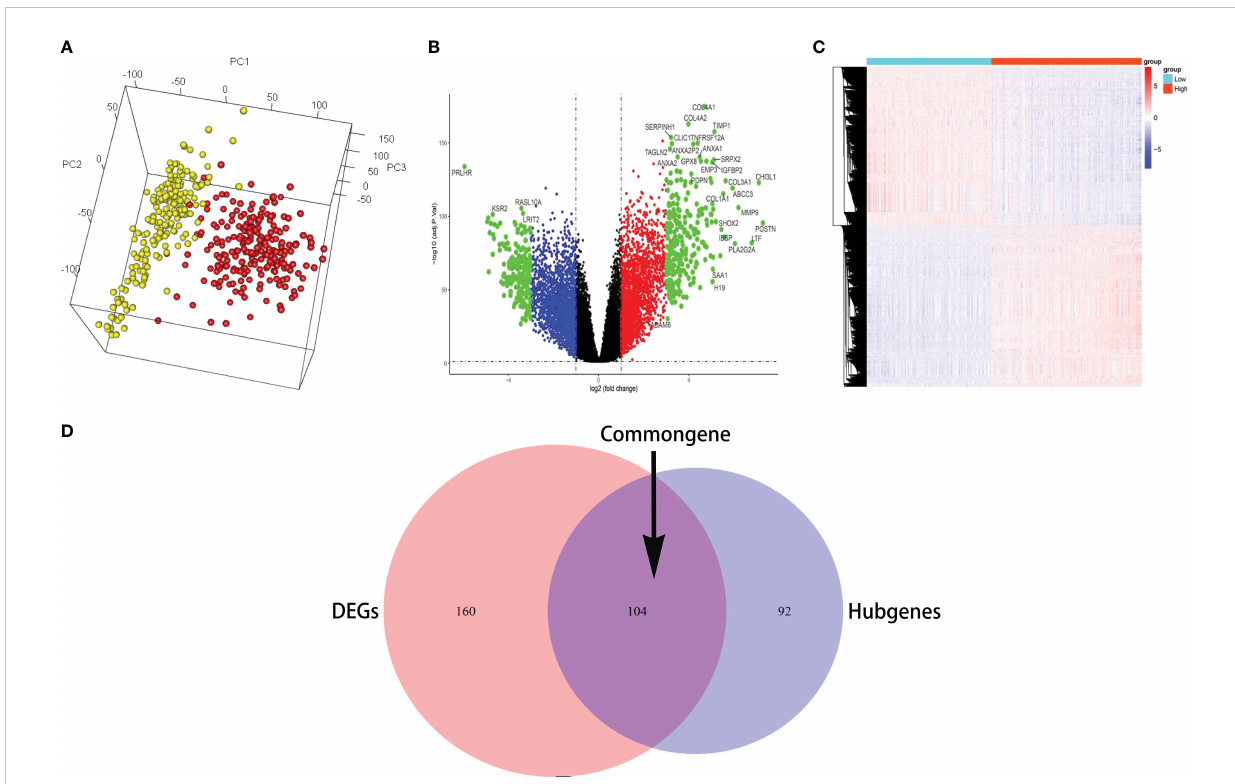
FIGURE 2 The common genes were identi fi ed. (A) The 3D PCA revealed the most homogeneity across tumor samples. (B) The volcano plot displayed the entire differential changes. (C) The clustering heatmap depicted the distribution of differentially expressed genes. (D) The Venn diagram displays the common genes between differential genes and hub